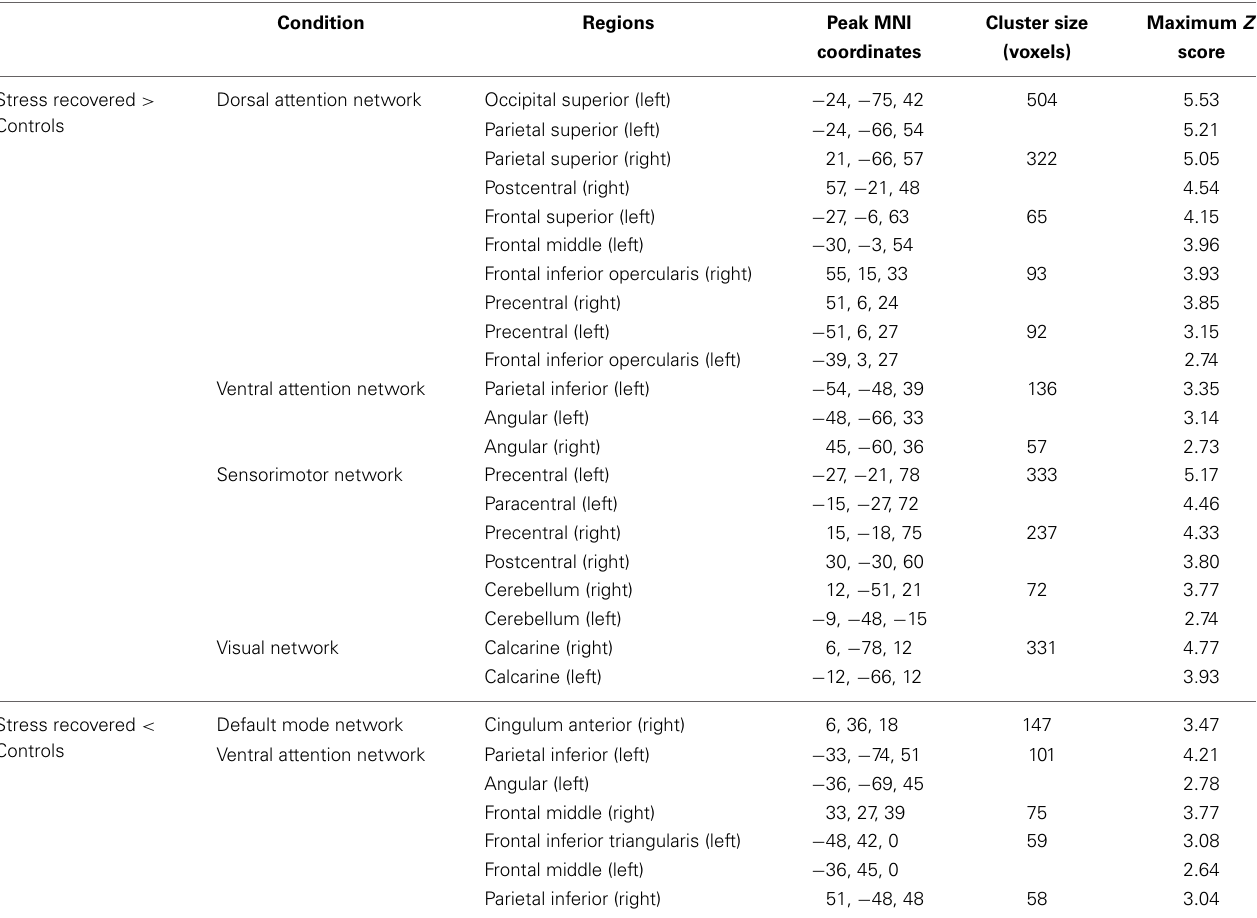
Table 2 | Group differences (Stress recovered vs. Controls) at rest, in brain regions of the DAN, VAN, SMN, VN, and DMNN maps (two sample t -tests, corrected for multiple comparisons, p < 0 .